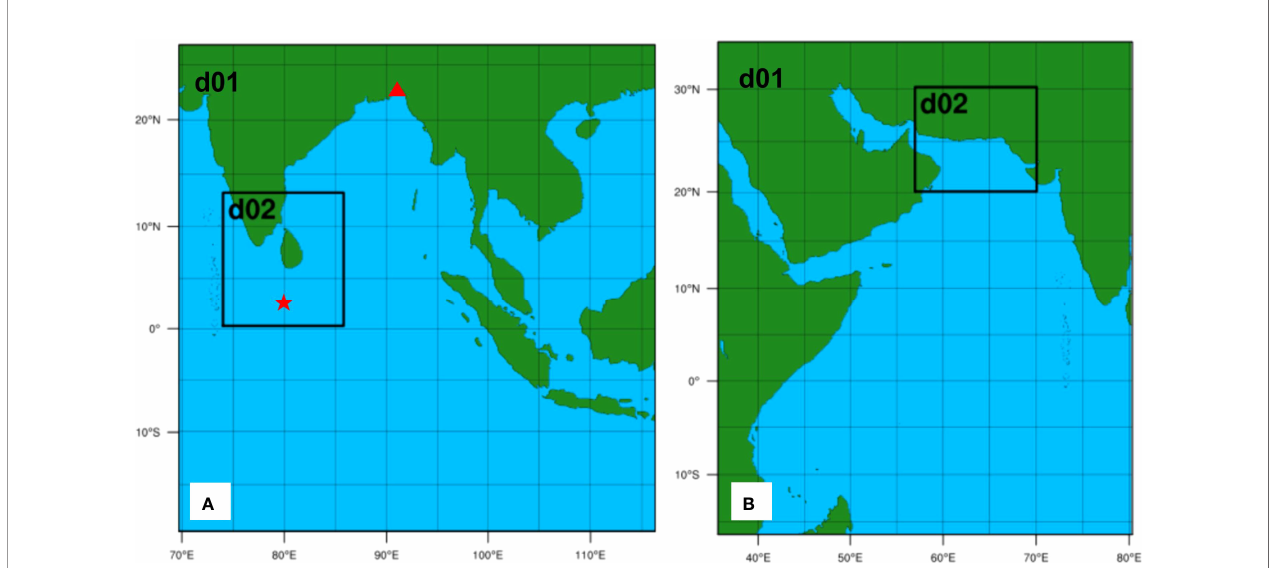
FIGURE 1 | Domains of the atmospheric model for the (A) eastern Indian Ocean (EIO) and (B) western Indian Ocean (WIO). The star and triangle are the locations of buoy observation and tide-gauge station Chittagong,